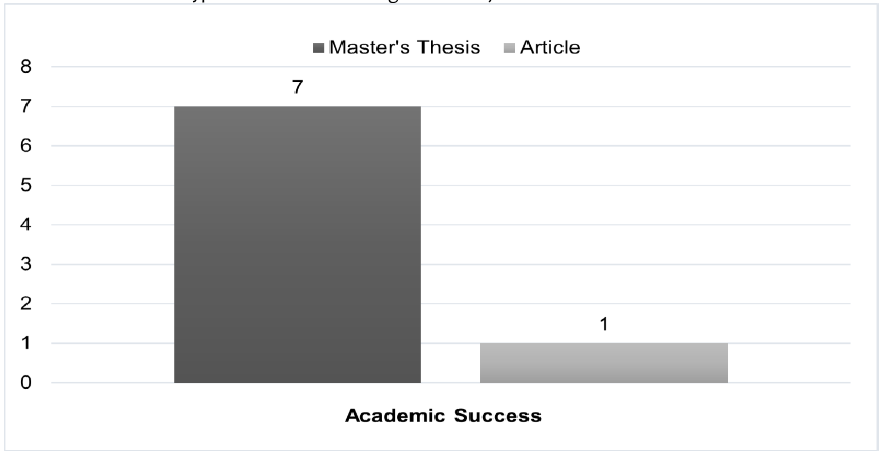
Figure 10: Distribution of type of Studies according to the subject of academic